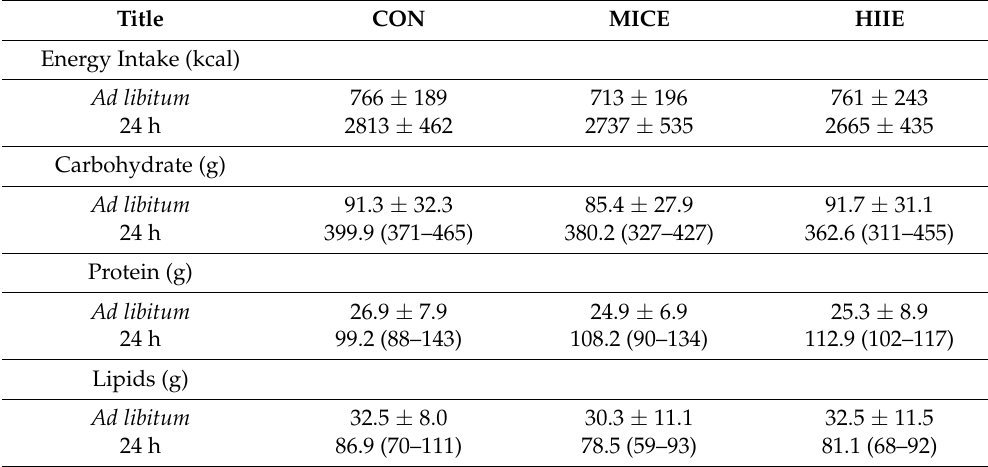
Table 2. Energy intake and macronutrients in ad libitum meal and throughout the day for the experimental sessions and